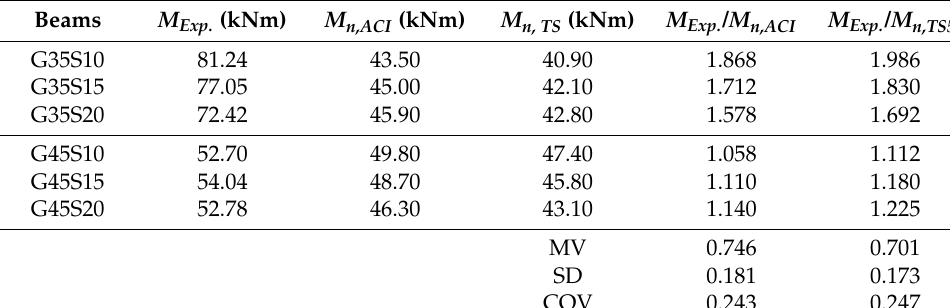
Table 5. Comparison of nominal moment predictions.